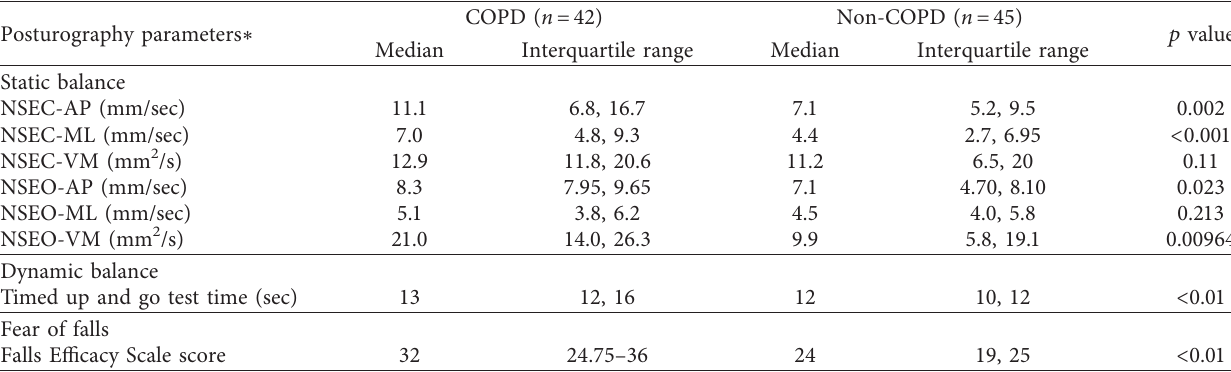
Table 3: Comparison of static and dynamic balance between COPD and Non-COPD individuals. Posturography parameters ∗